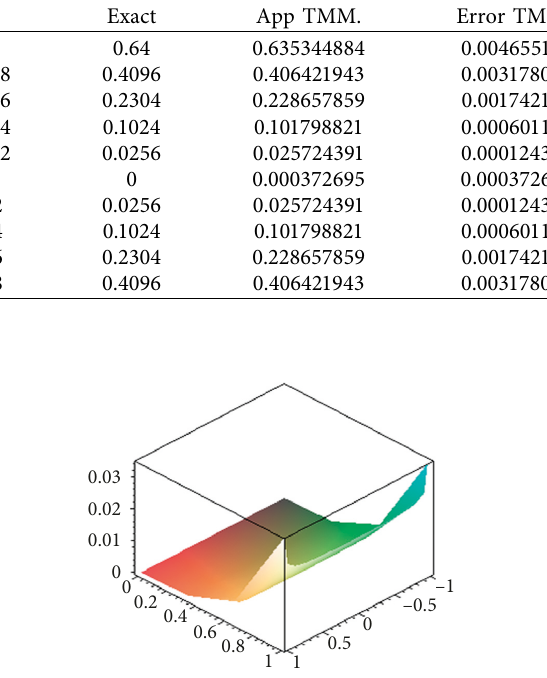
Figure 5: The error of super strong singular logarithmic kernel at. k k, T 0 . (cid:27) (cid:27)